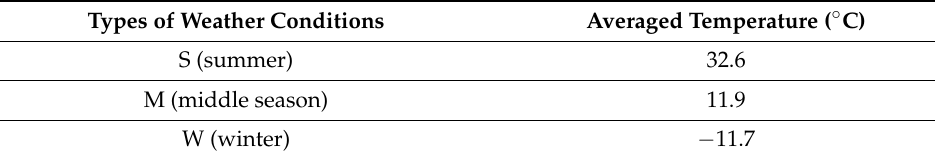
Figure 4. Annual daily averaged outdoor air temperature. Table 3. Averaged outdoor air temperature for representative days.